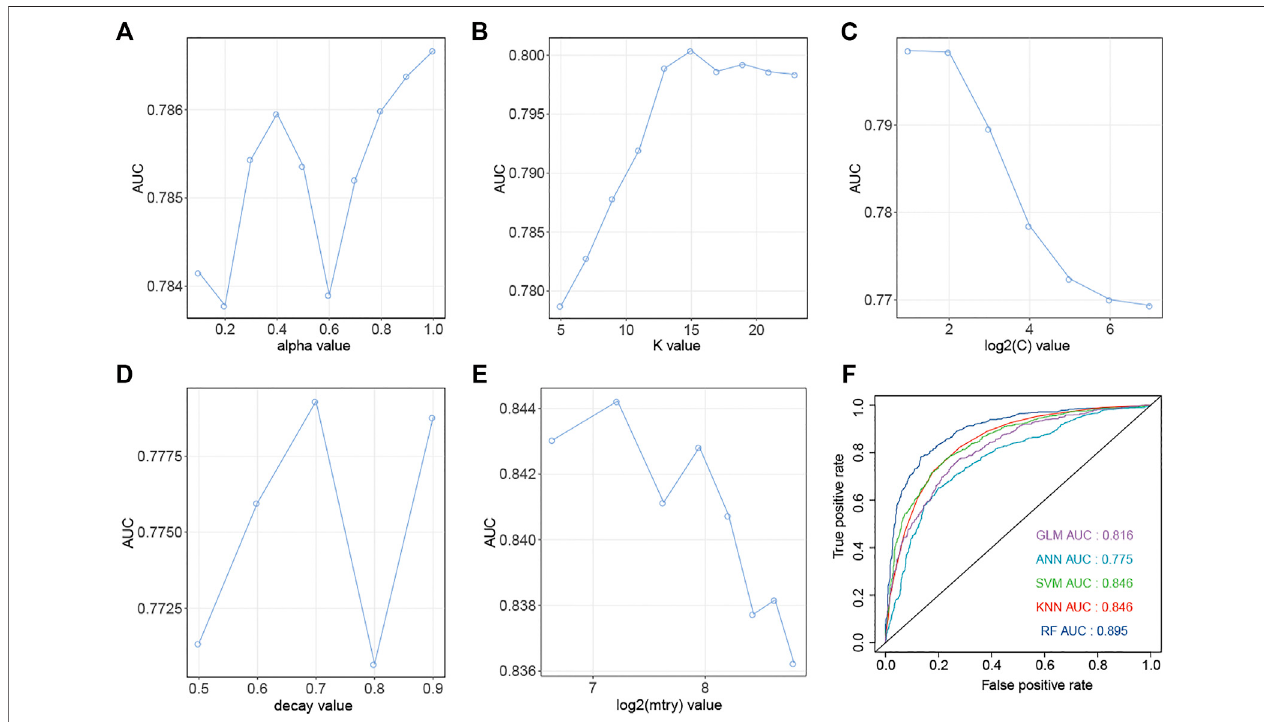
FIGURE 4 | Prediction performance of models for SM-miRNA down-regulation pairs. (A – E) AUC values of 5 machine learning algorithms are generated by the 5- fold cross validation on the training dataset. (A) Generalized Linear Models (GLM). (B) K-nearest Neighbors (KNN). (C) Support Vector Machine (SVM). (D) Gradient Boosting Machine (GBM). (E) Random Forest (RF). (F) AUC values of 5 models were calculated on the testing dataset.